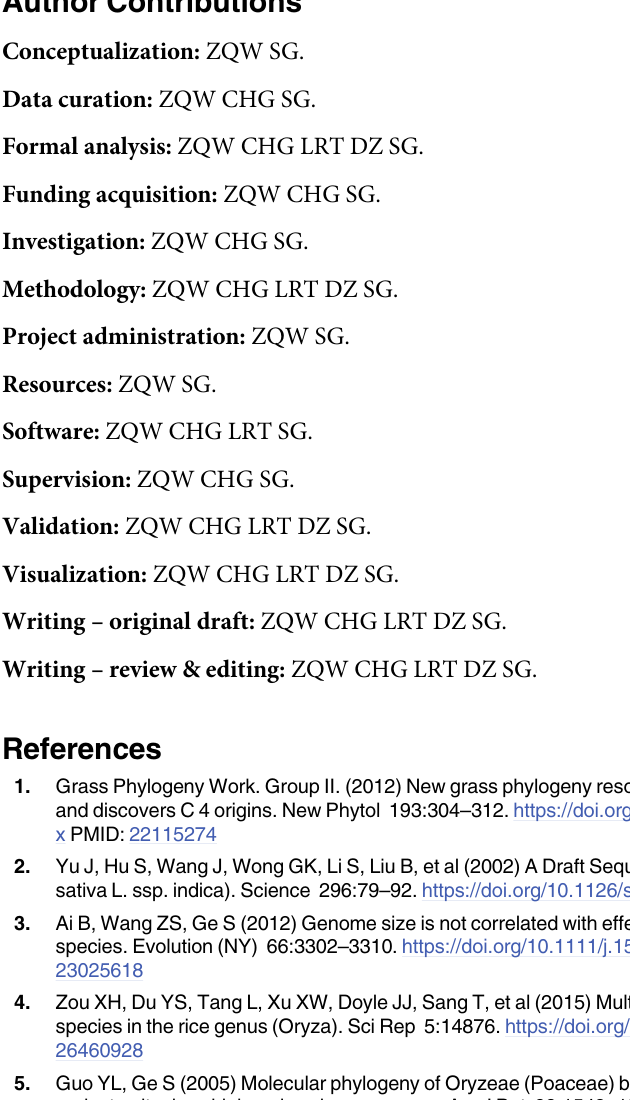
S1 Table. Gene content encoded in the C . mutica chloroplast genome. S2 Table. Polymorphic information from comparisons between two Chikusichloa